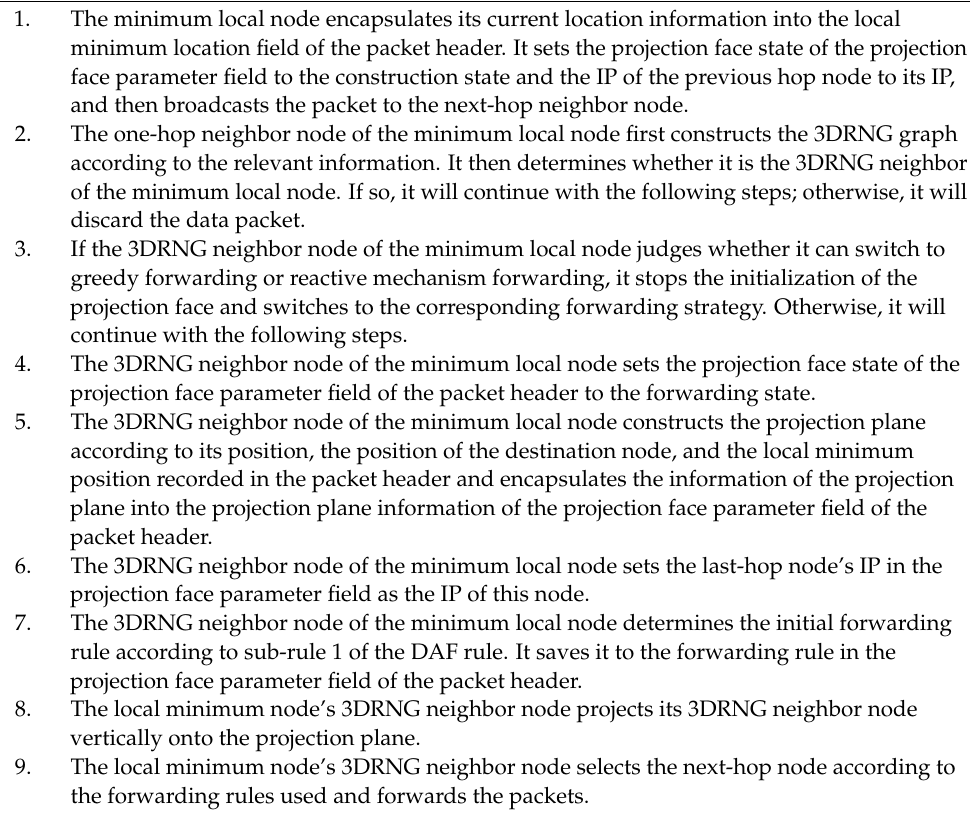
Algorithm 4: RGF initialization process of projection face forwarding protocol